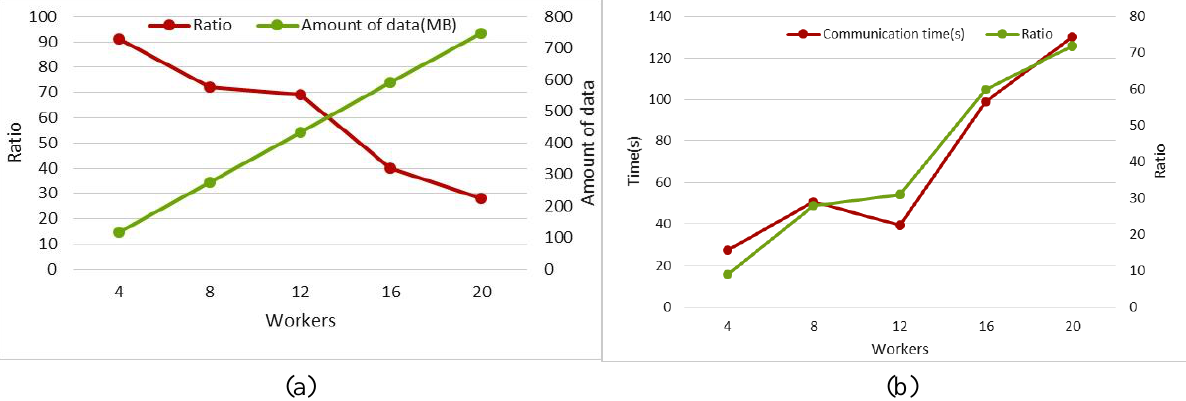
Figure 9. Transferred data in Mb and ratio of computation to total time in Job 1 (a). Communication time and ratio of communication to total time in Job 1